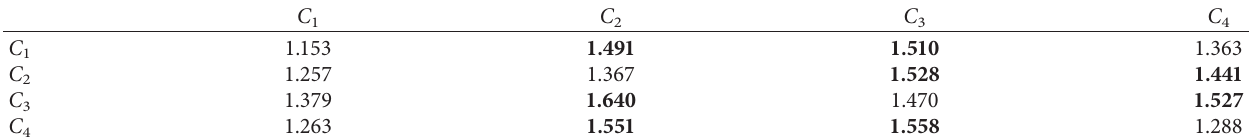
Table 4: Defuzzified centroid matrix Y